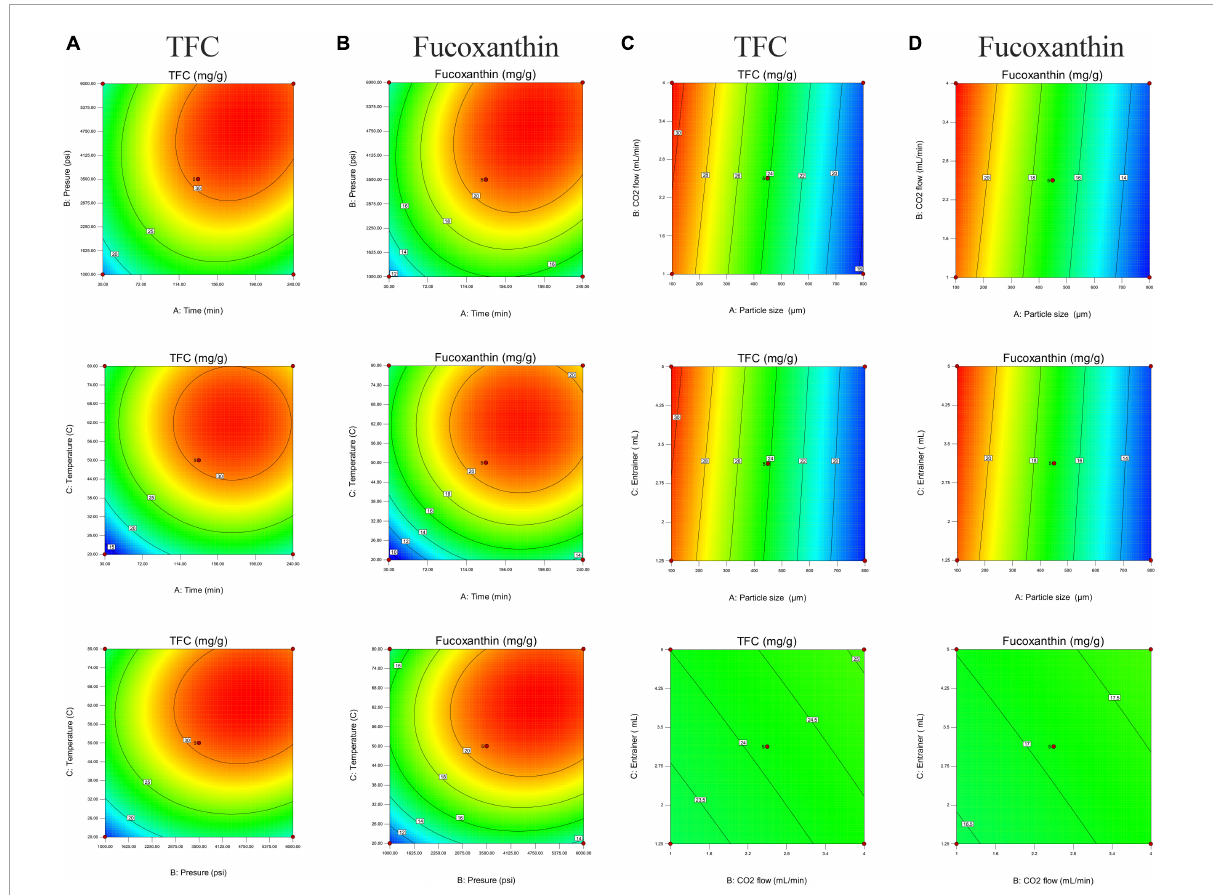
FIGURE3 Two-dimensional contour graphs of plots with the optimal points for the total flavonoid (TFC) and fucoxanthin content (mg/g) in the extract. (A,B) TFC and fucoxanthin versus the particle size (450 µ m), CO 2 flow (2.5 ml/min), and entrainer (1.25 mL). (C,D) TFC and fucoxanthin versus the extraction time (135 min), pressure (3500 psi), and temperature (50 ◦